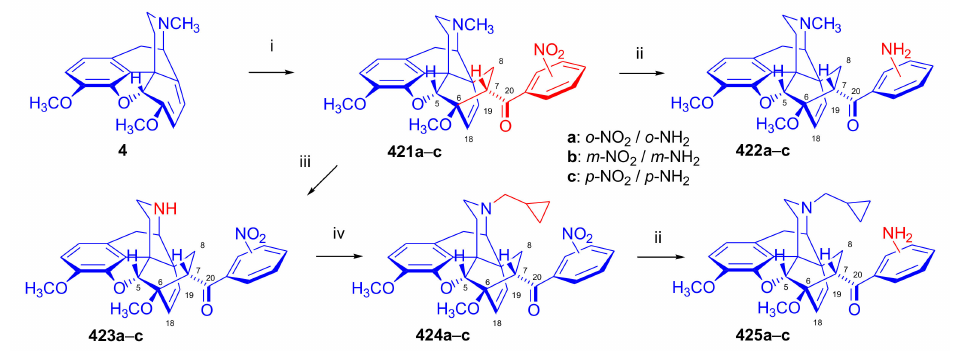
Figure 106. Synthesis of nepenthone analogues. Reagents and conditions : (i): ( o -, m -, p -)-nitrophenyl vinyl ketones, toluene, reflux; (ii): Raney-Ni, 85% hydrazine hydrate, ethanol, 60 ◦ C; (iii): (1) DEAD, benzene, reflux, (2) 1M hydrochloric acid, 70–80 ◦ C; and (iv): cyclopropylmethyl bromide, K 2 CO 3 , DMF, 80–90 ◦ C, 10